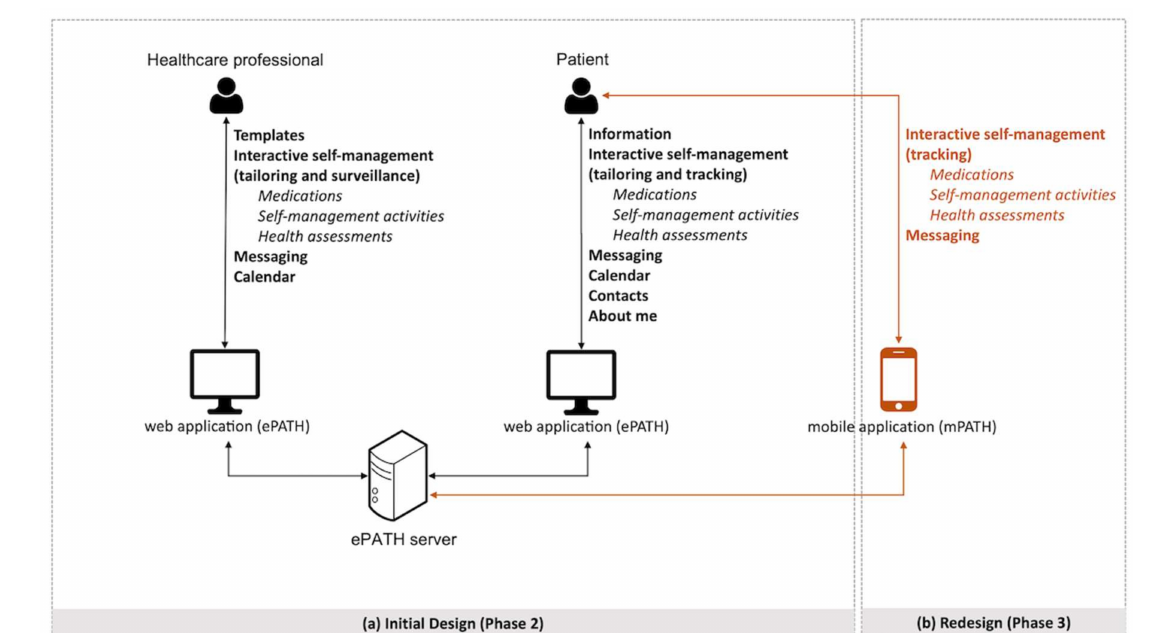
Figure 2. Overview of ePATH architecture and modules for different users: ( a ) illustrates the initial design (phase 2), which enabled all users to access ePATH through a web-based application; ( b ) illustrates how the web-based application was complemented with a patient-facing mobile application and related functionalities for patients after redesign (phase